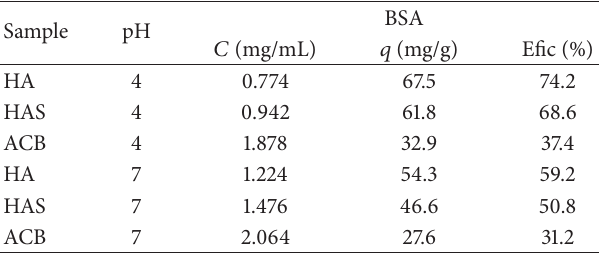
Table 2: Concentration of the solution ( 𝐶 ), adsorption capacity ( 𝑞 ), and adsorption efficiency (efficiency) of bovine serum albumin (BSA) after 24 h at room temperature in pH (4.0 and 7.0).